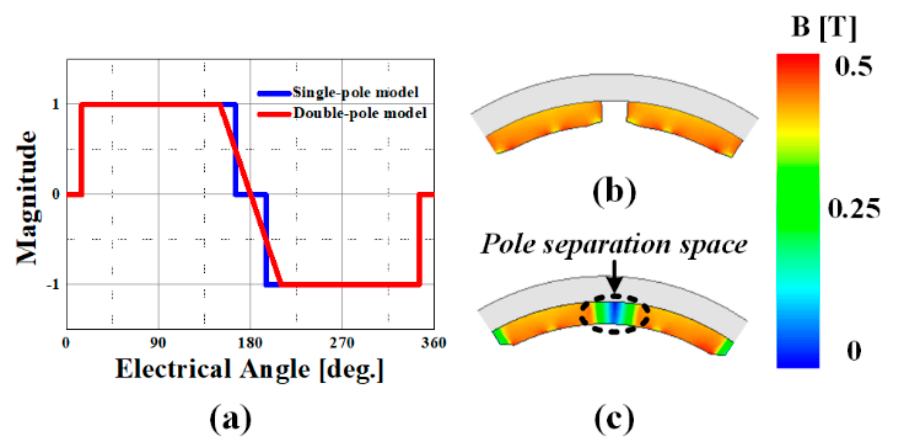
Figure 3. ( a ) Magnetization pattern function. Magnetic flux density distribution: ( b ) Single-pole model and ( c ) double-pole model.